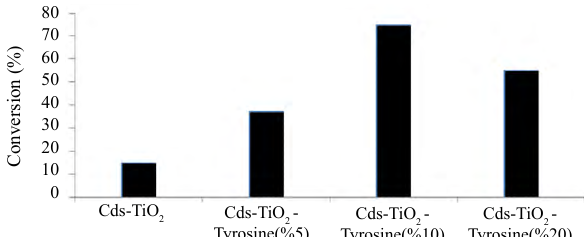
Fig. 11. The effect of amount of loaded amino acid on the conversion (%) of NB (catalyst: 0.1 g, NB: 0.0136 M, irradiation time: 120 min, pH: neutral)